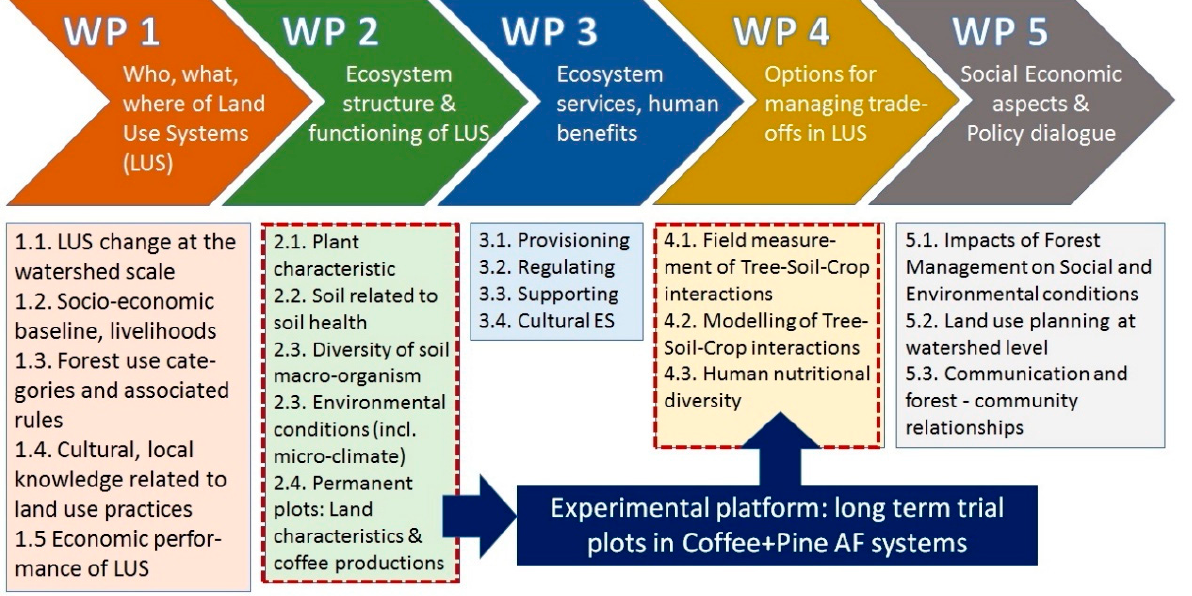
Figure 2. Project overview showing how the physical research platform supports, and is integrated, within the wider UB research on land use systems (LUS) and ecosystem services (ES) and the overall project objective to support sustainable and equitable pine-coffee agroforestry management.